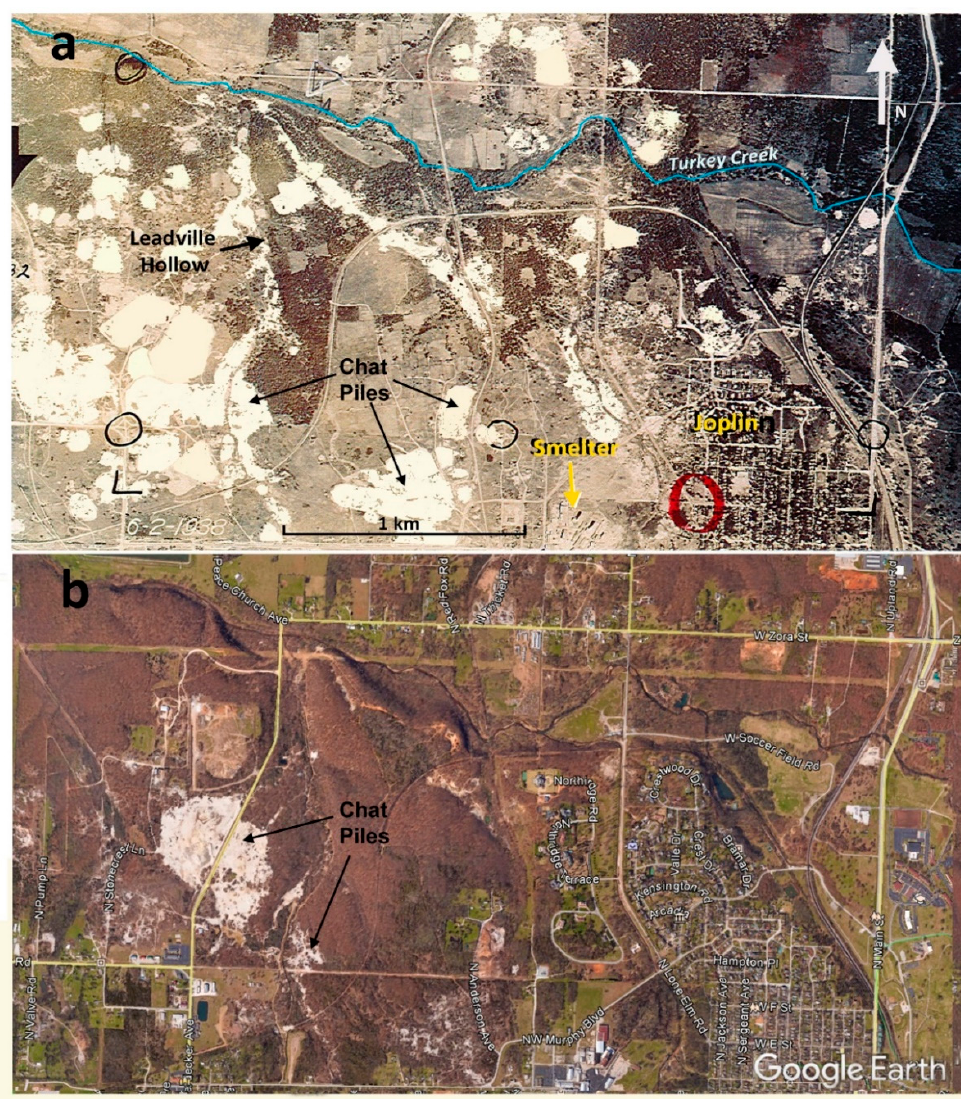
Figure 2. Location of mining wastes (chat piles in white) in a portion of the TSMD near the northern edge of Joplin, Missouri, in ( a ) 1938 and ( b ) 2018. Note the reduction of chat piles in 2018 (b) as compared to 1938 (a). Note: The original 1938 photo had some markings (black and red circles); those markings are not related to this study.